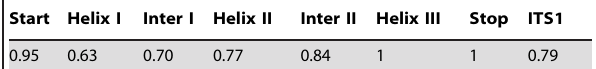
The ‘‘Start’’ and ‘‘Stop’’ region marked in the Table represent the nucleotides before the first and after the third helix, respectively. ‘‘Inter 1’’ and ‘‘Inter 2’’ represent interhelical regions between first and second and second and third helix,